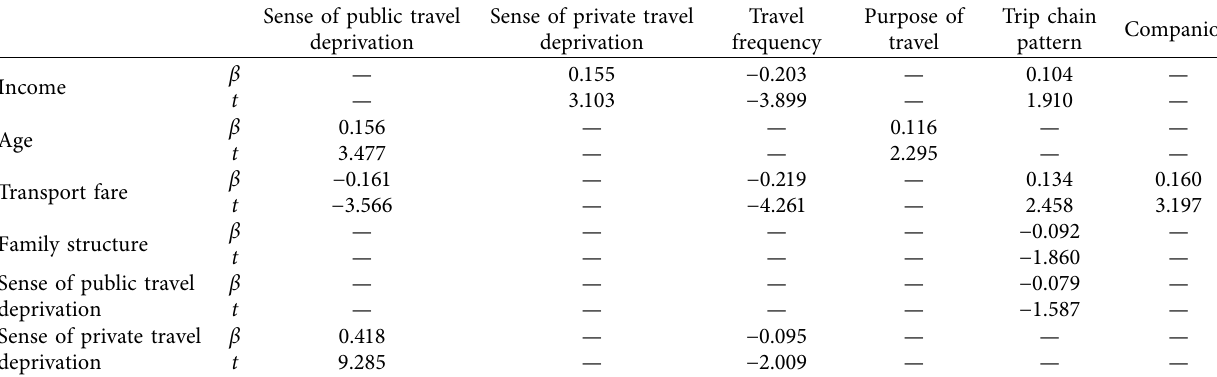
Table 3: Impacts of the sense of travel deprivation on travel